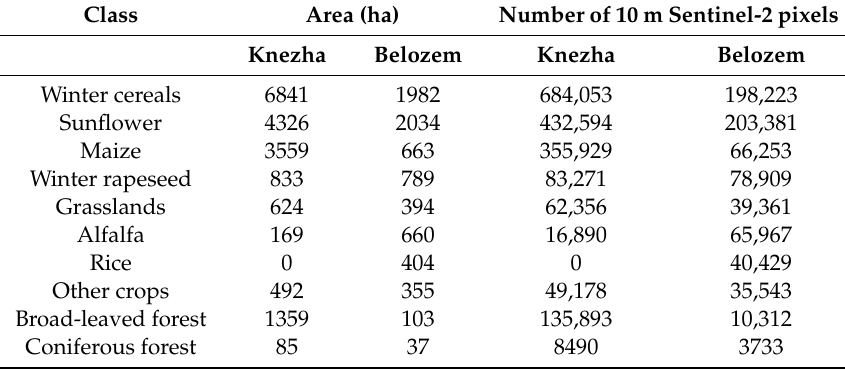
Table 1. Size of the reference training dataset per class expressed as an area and number of 10 m Sentinel-2